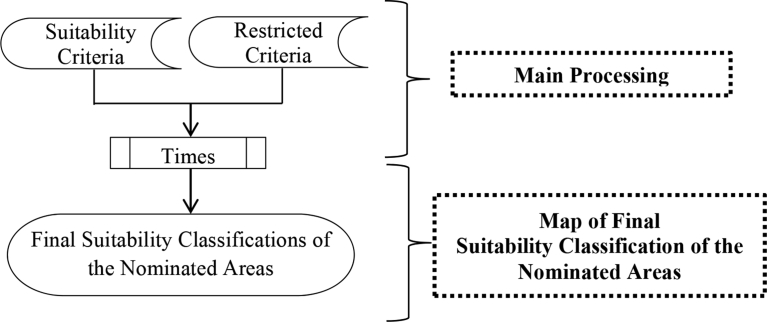
Flow Chart of GIS Suitability Classifications of the Nominated areas.